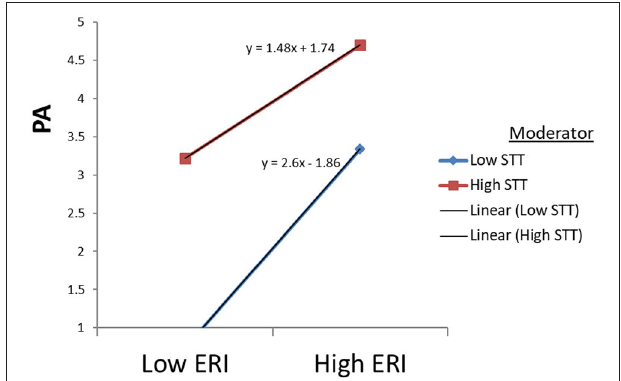
FIGURE 3 | Moderating effects of STT on PA through PA.